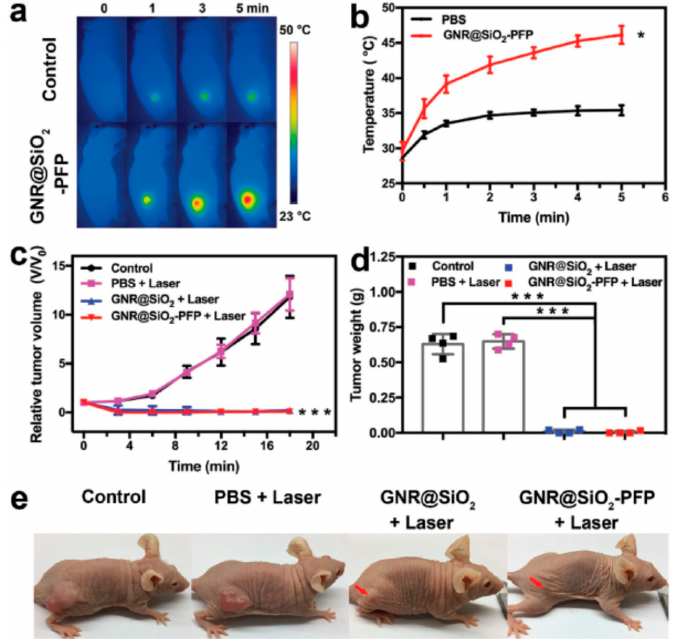
Figure 14. In vivo studies in A375 tumor-bearing mice of GNR@SiO2-PFP nanorattles. ( a ) Thermographic images and ( b ) Temperature change after laser irradiation at 24 h post-injection (*